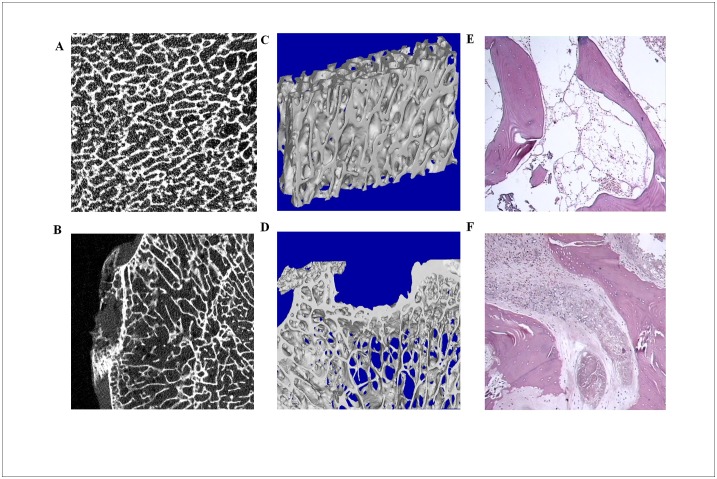
TIONFH patient bone collapse and osteoblast death.(A) Micro-CT of a normal area. (B) Micro-CT of a necrotic area, which appeared to indicate trabecular bone disorder, shows structural relaxation. (C) Three-dimensional reconstruction of normal areas. (D) Three-dimensional reconstruction of a necrotic area showing trabecular bone collapse deformation. (E) HE staining of normal areas. (F) HE staining of a necrotic area shows significant bone necrosis and bone marrow tissue necrosis between the trabecular and simultaneous granulation tissue.